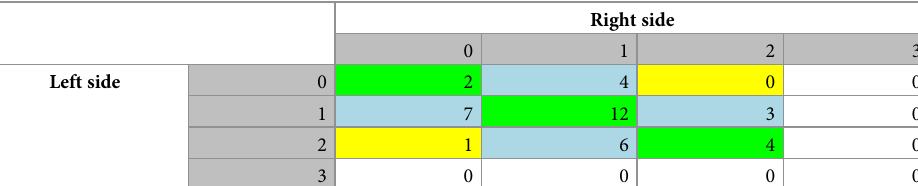
Table 1. Contralateral